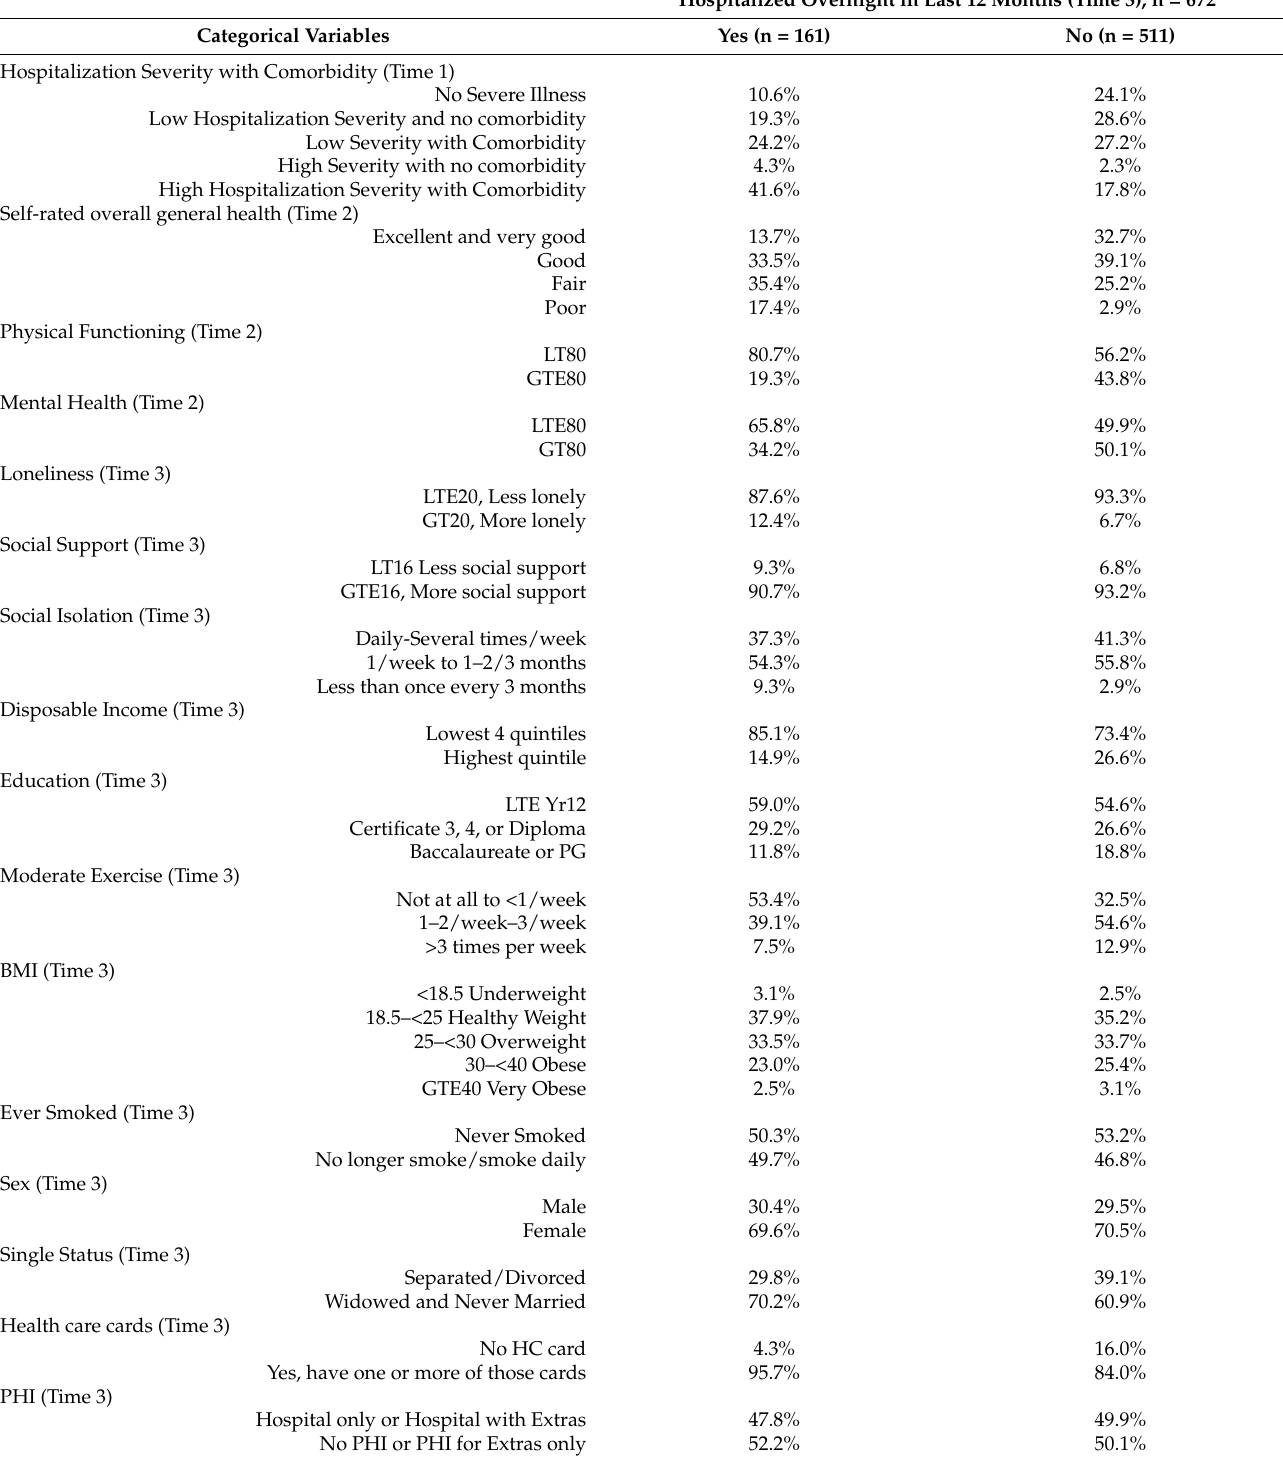
Table 1. The number of respondents for each of the categories used in the analyses by overnight hospitalization at Time